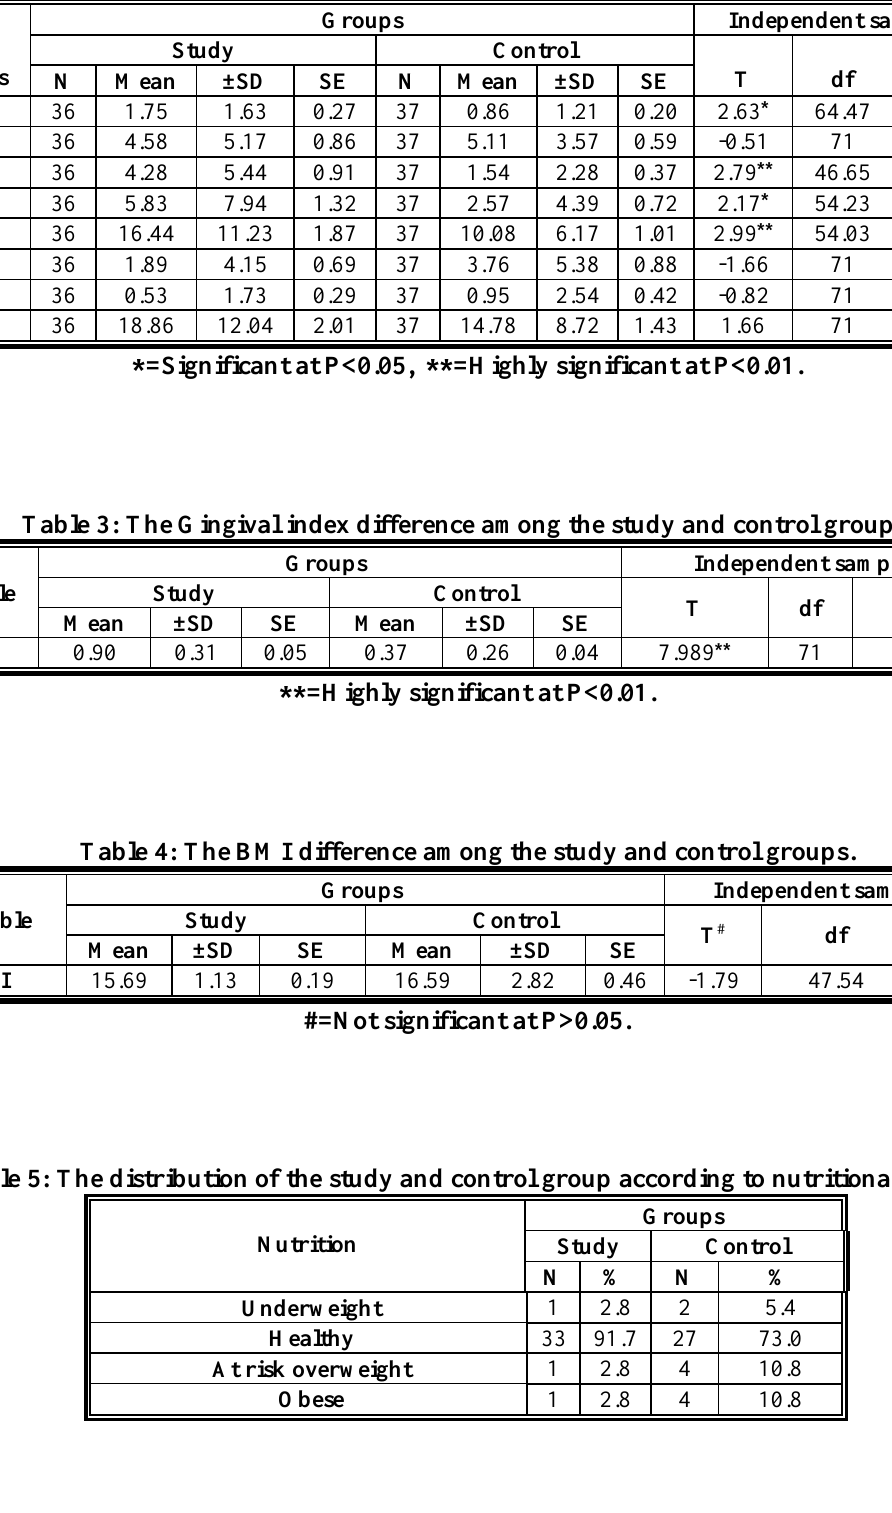
Table 2: Caries experience and caries severity differences between study and control groups for primary dentition.